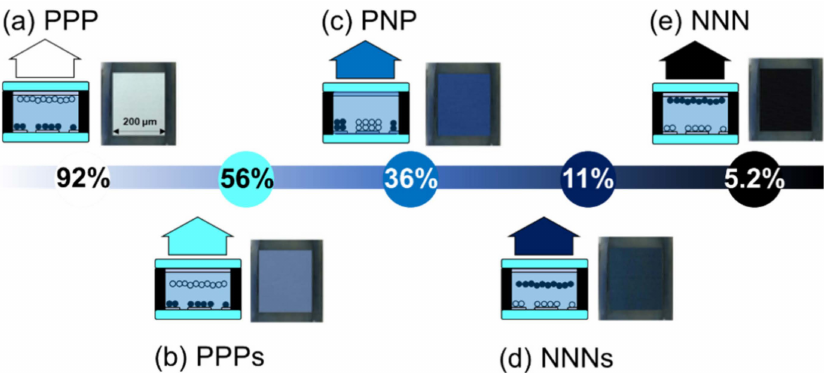
Figure 6. Schematic illustrations for the arrangement of the particles controlled by the voltage application and their reflectivity from 5.2% to 92% in reflective type E-paper. These experimental results included the reflectance of the